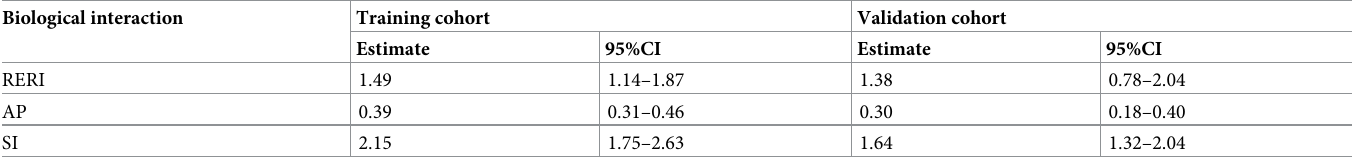
Table 5. Measures for estimation of biological interaction between AHF and AKI for the risk of in-hospital mortality in patients with sepsis. Biological interaction